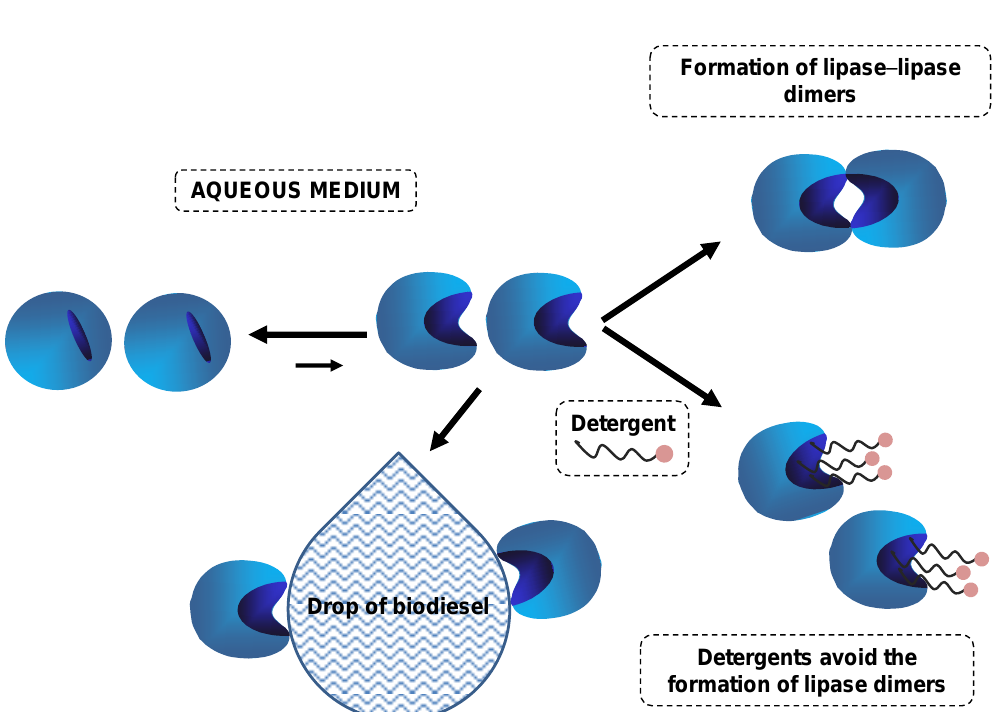
Figure 15. The tendency of lipase to give lipase–lipase dimers may be avoided by the addition of detergents or the interfacial activation on drops of biodiesel.